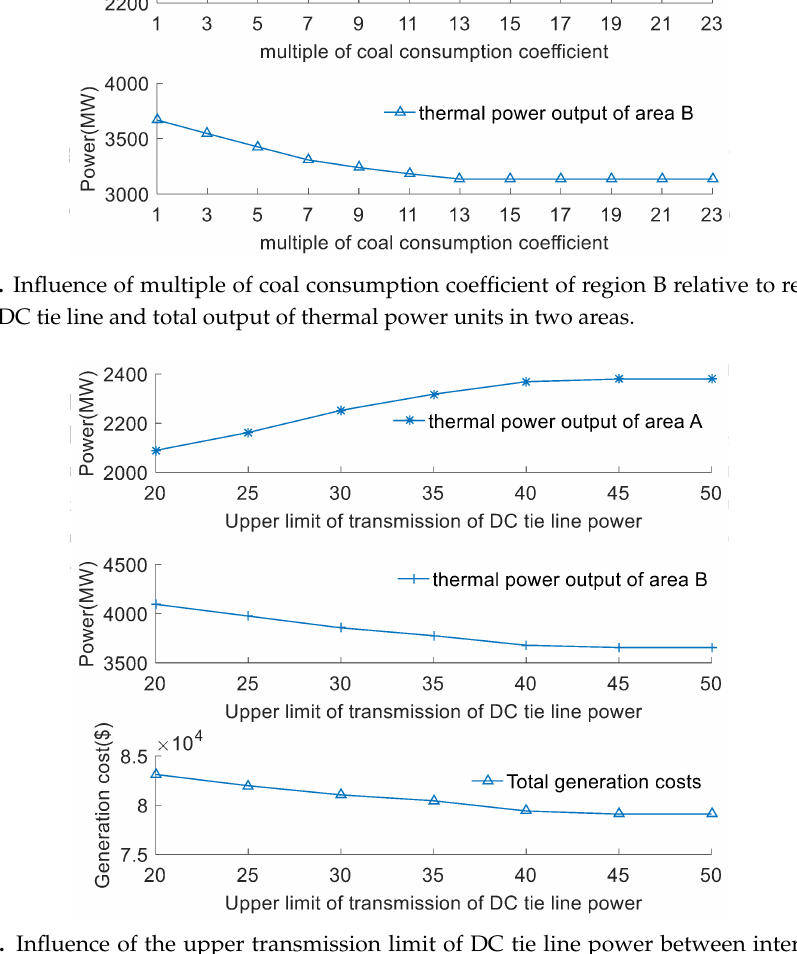
Figure 11. Influence of the upper transmission limit of DC tie line power between interconnected regions on the total output of thermal power and total generation cost in two